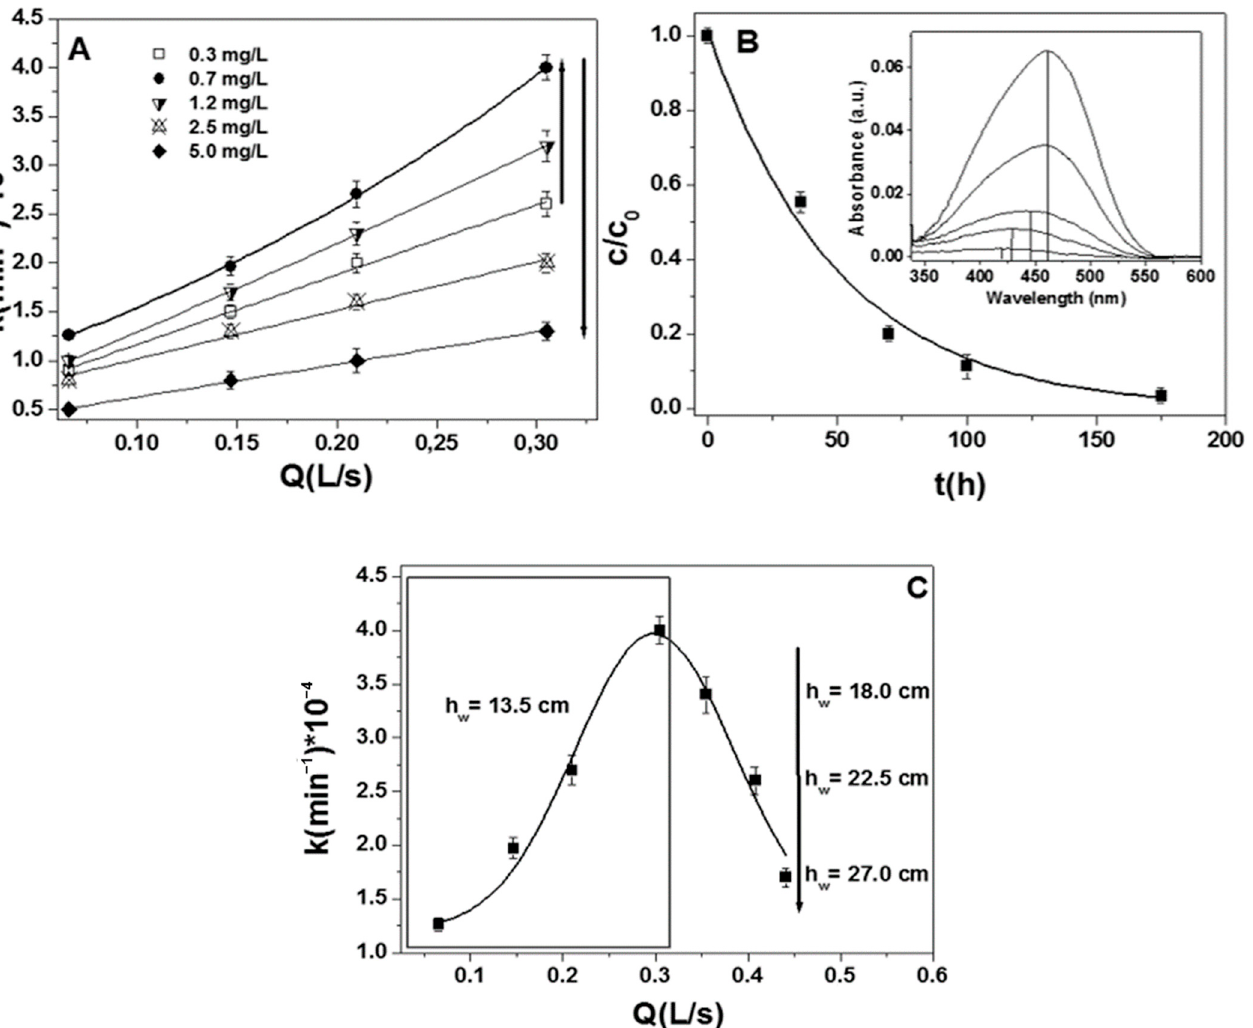
Figure 4. ( A ) Influence of the flow rate at different dye concentrations (TiO 2 = 0.79 g/cm 3 , h w = 13.5 cm, tests no. 7, 8, 9, 10). ( B ) kinetic curve relative to the experiment carried out with MO = 0.7 mg/L; TiO 2 = 0.79 g/cm 3 , Q = 0.305 L/h, h w = 13.5 cm and in the inset the relative UV–vis absorption spectrum decay. ( C ) kinetics obtained at different hydraulic parameters (flow rate Q , hydraulic load h w , MO = 0.7 mg/L; TiO 2 = 0.79 g/cm 3 , tests no. 7–13).